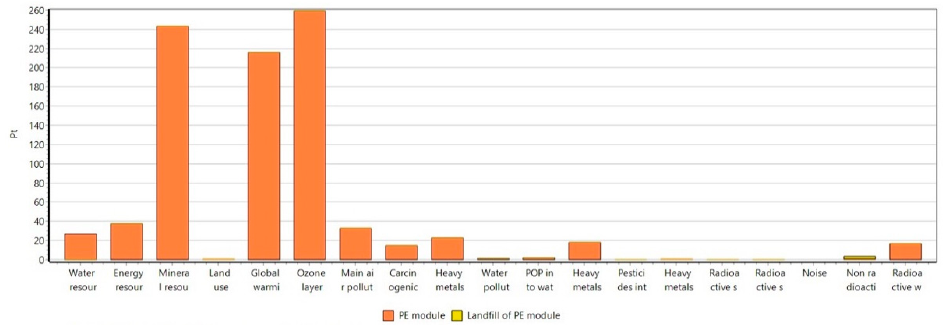
Figure 1. LCA Results for the PZT module according to the Ecological Scarcity 2013 Method .